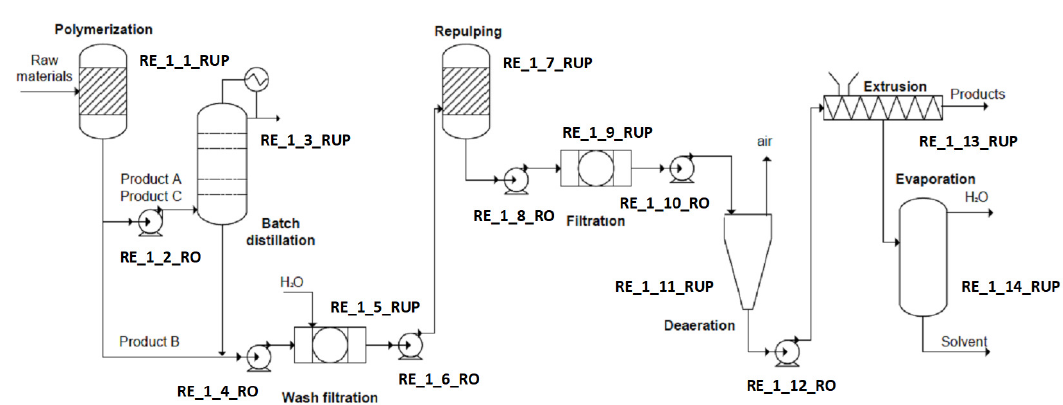
Figure 8. Flowsheet for acrylic fibers’ production process (it contains 14 recipe elements, divided into eight recipe unit procedures and six recipe